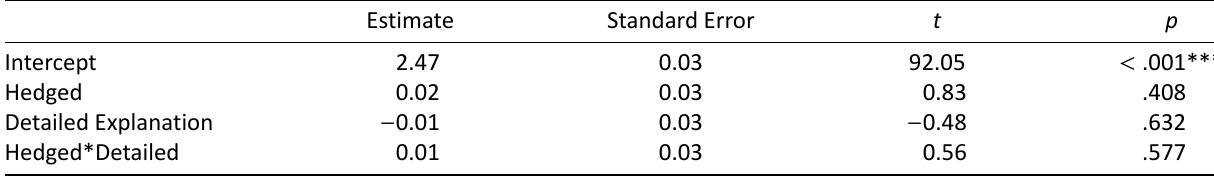
Figure 5. Average aggregated resistance of corrective information (1–7 Likert-scale) by condition. Notes: N = 1,589. Error bars reflect 95% confidence intervals. Table 3. General linear model predicting information resistance by correction style